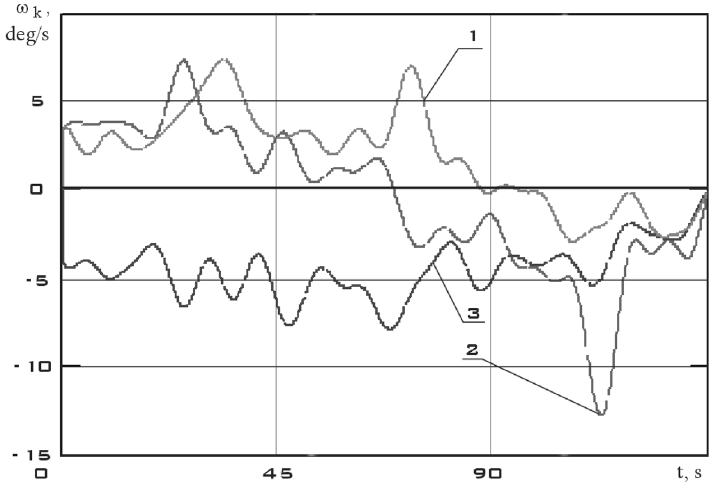
Figure 16. There are components of the angular velocity vector in the CXYZ coordinate system. 02/15/2014 from 12:00:06 to 12:02:21 (1 is ω x ; 2 is ω y ; 3 is ω z ).